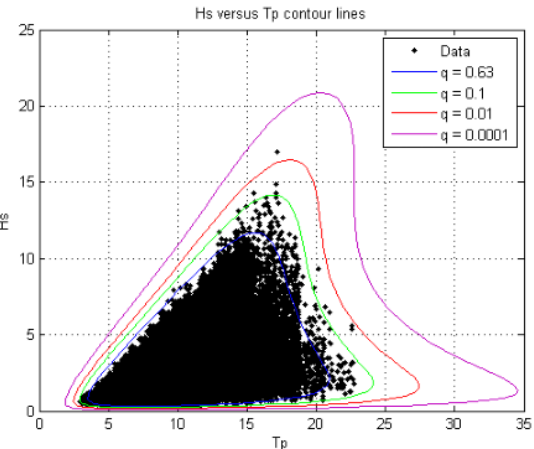
Figure 2. Environmental contour lines for Haltenbanken; q is the annual prob. of exceedance. Reproduced from [20] with permission from lead author.